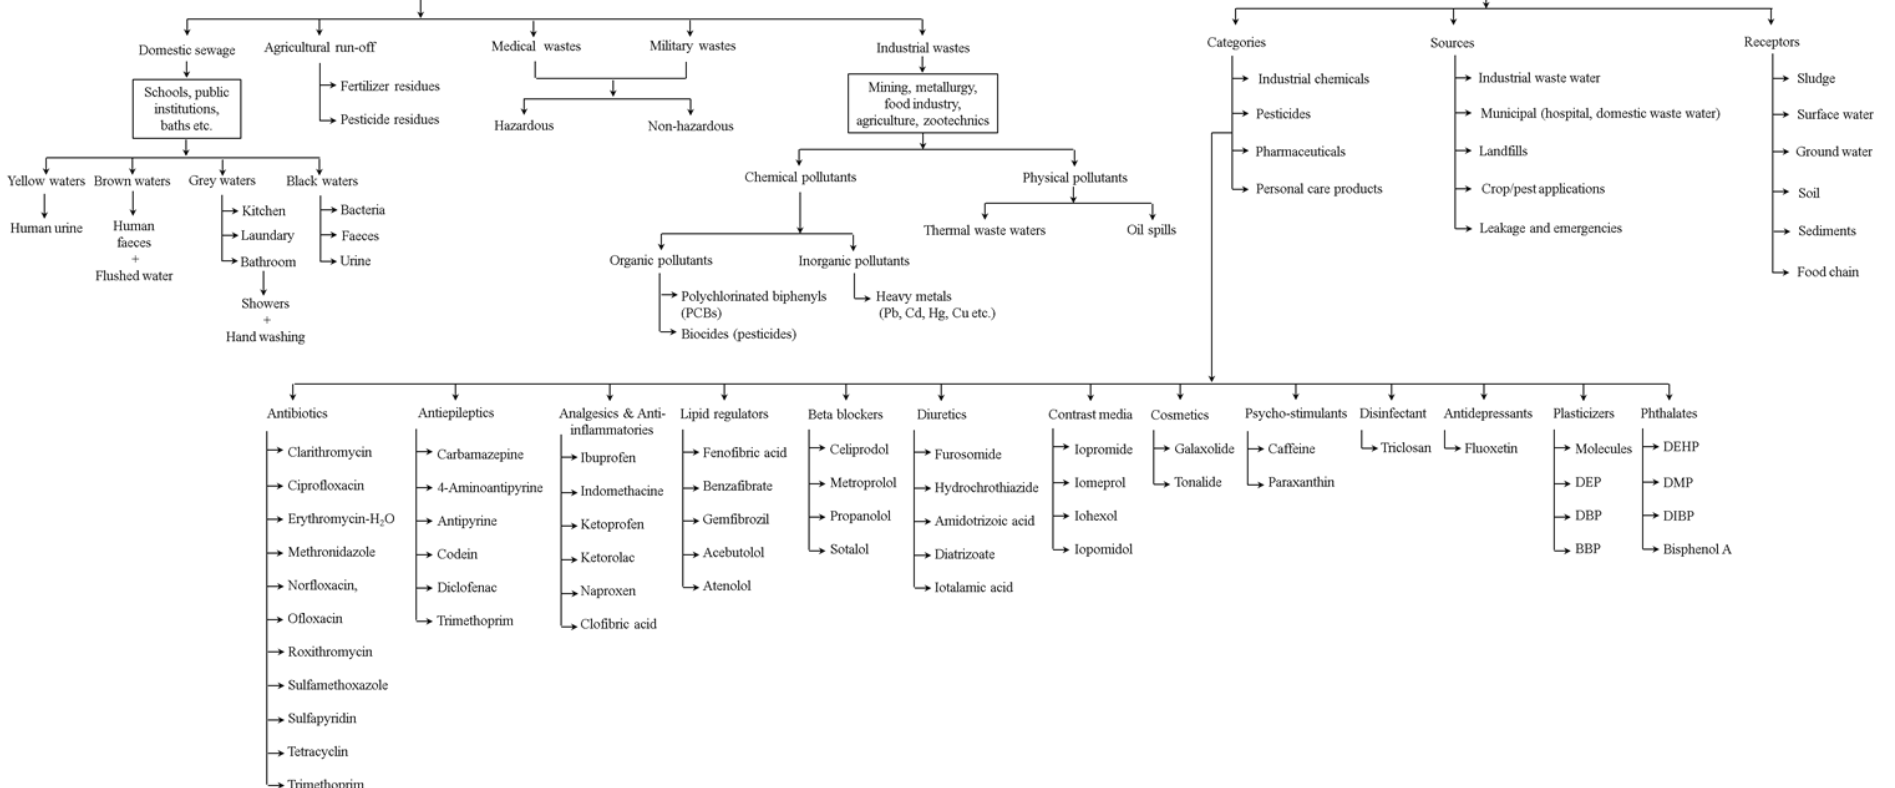
Figure 1. Water pollution: sources and emerging contaminants.